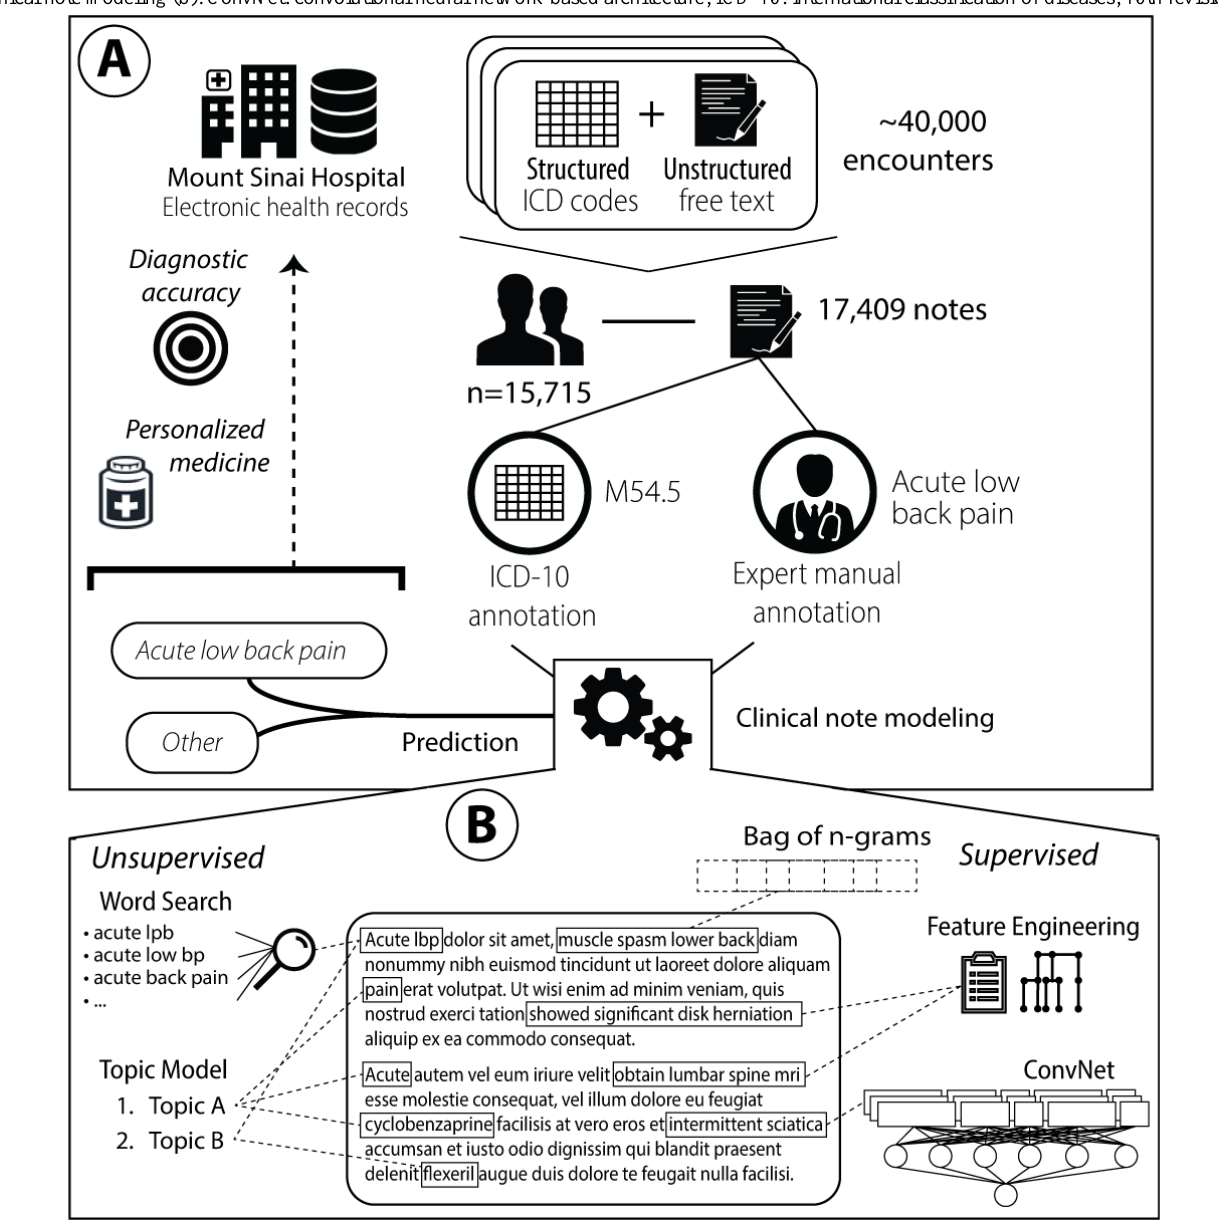
Figure 1. Conceptual framework used to evaluate the use of automated approaches based on machine learning and information retrieval to analyze free-text clinical notes and identify acute low back pain episodes (a). The various unsupervised and supervised machine learning approaches used